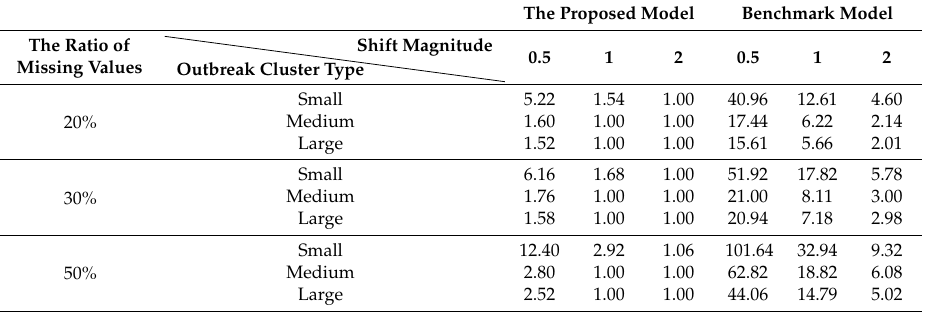
Figure 6. LR statistics using the benchmark model for detecting the medium outbreak cluster. ( a ) shift magnitude = 0.5, 20% missing values; ( b ) shift magnitude = 1, 20% missing values; ( c ) shift magnitude = 2, 20% missing values; ( d ) shift magnitude = 0.5, 30% missing values; ( e ) shift magnitude = 1, 30% missing values; ( f ) shift magnitude = 2, 30% missing values; ( g ) shift magnitude = 0.5, 50% missing values; ( h ) shift magnitude = 1, 50% missing values; ( i ) shift magnitude = 2, 50% missing values. Table 1. ARL 1 values of the proposed model and benchmark model in the simulation case. The Proposed Model Benchmark Model The Ratio of TypeShift Missing Values Outbreak Cluster